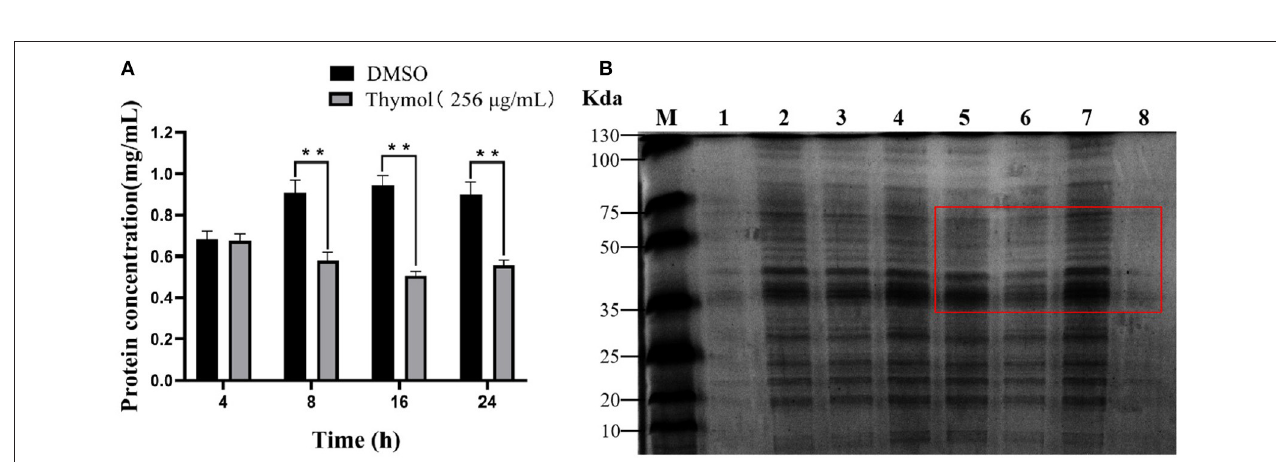
FIGURE 4 | Effect of 2MIC thymol on soluble protein of S. iniae strain HT. (A) Thymol decreased the total protein concentration of HT (B) SDS-PAGE analysis results. Lane M, maker; lanes 1, 3, 5 and 7, untreated cells for 4, 8, 16 and 24h, respectively; lanes 2, 4, 6 and 8, treated cells with thymol for 4, 8, 16 and 24h, respectively. ** p < 0.01 when compared with control